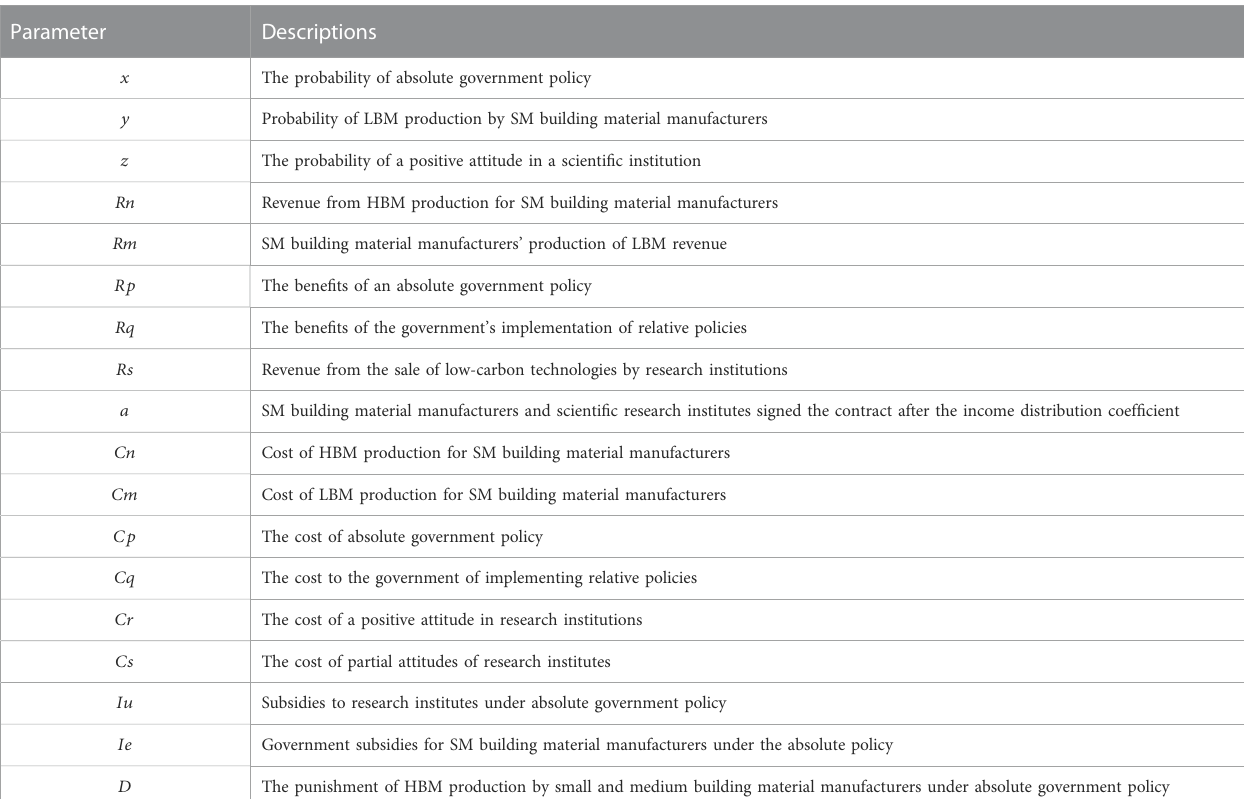
TABLE 1 Description of signi fi cant